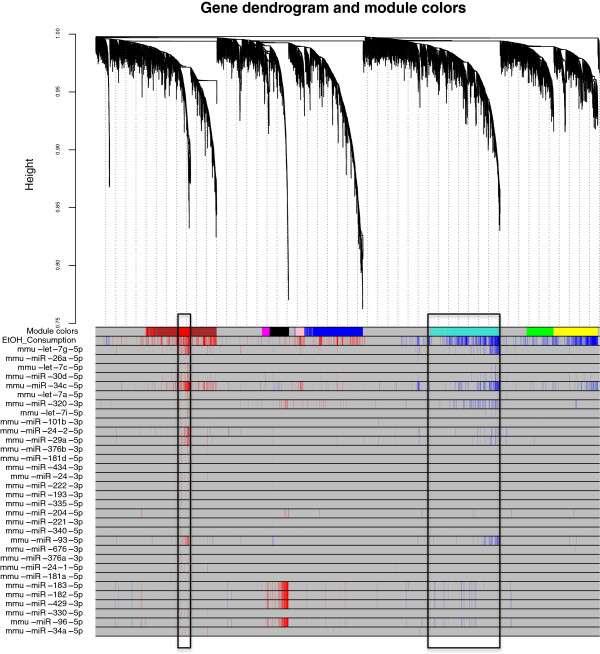
Gene dendrogram, module assignment, and correlation to individual traits of interest. The network was created from the weighted correlation matrix generated by WGCNA, by first calculating the adjacency matrix and then calculating topological overlap (TO) to hierarchically cluster genes into coexpression modules (see Materials and Methods). Final module assignments were made based on module membership. (Upper) Cluster dendrogram groups genes into distinct modules. The y-axis represents a dissimilarity distance (1 - TO). Dynamic tree cutting was used to determine modules, by dividing the dendrogram at significant branch points. (Lower) Correlation between individual genes and traits of interest (ethanol consumption and miRNA expression) with FDR < 0.10 are shown as color coded lines: red line indicates positive correlation and blue line indicates negative correlation). Red and turquoise modules (encased by rectangles) appear preferentially targeted by differentially expressed miRNAs.